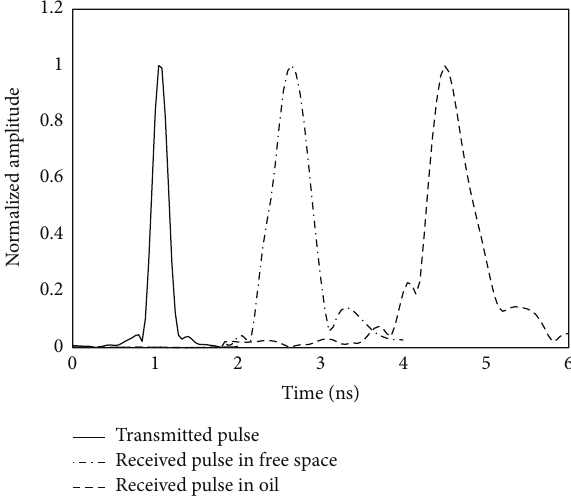
Figure 12: Measured response of the proposed antenna.